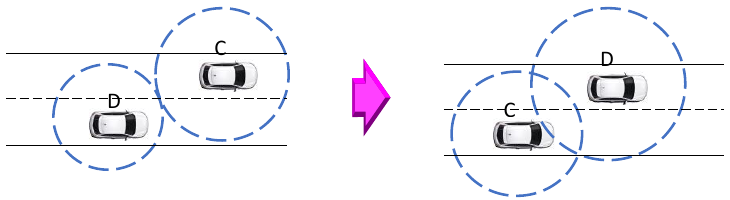
Figure 8. Conceptual illustration of the topological vehicle sequence shown in Figure 7.